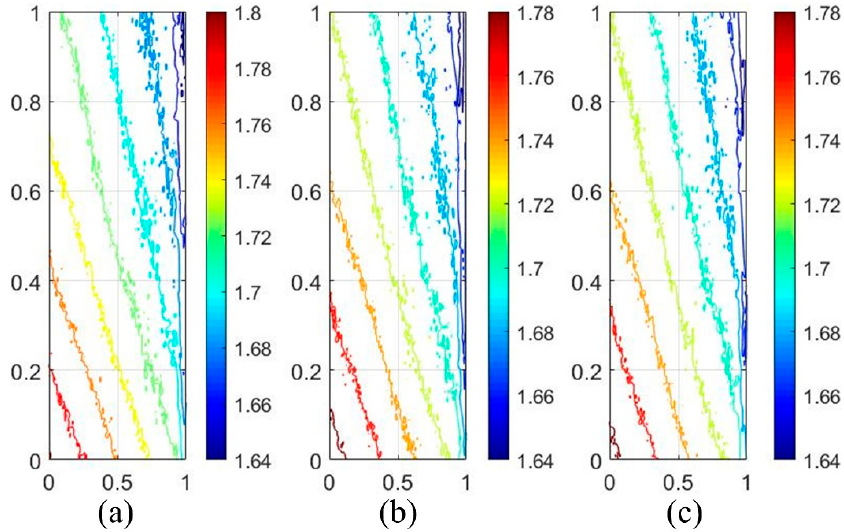
Figure 13. Displacement extraction algorithm based on 3D point clouds.